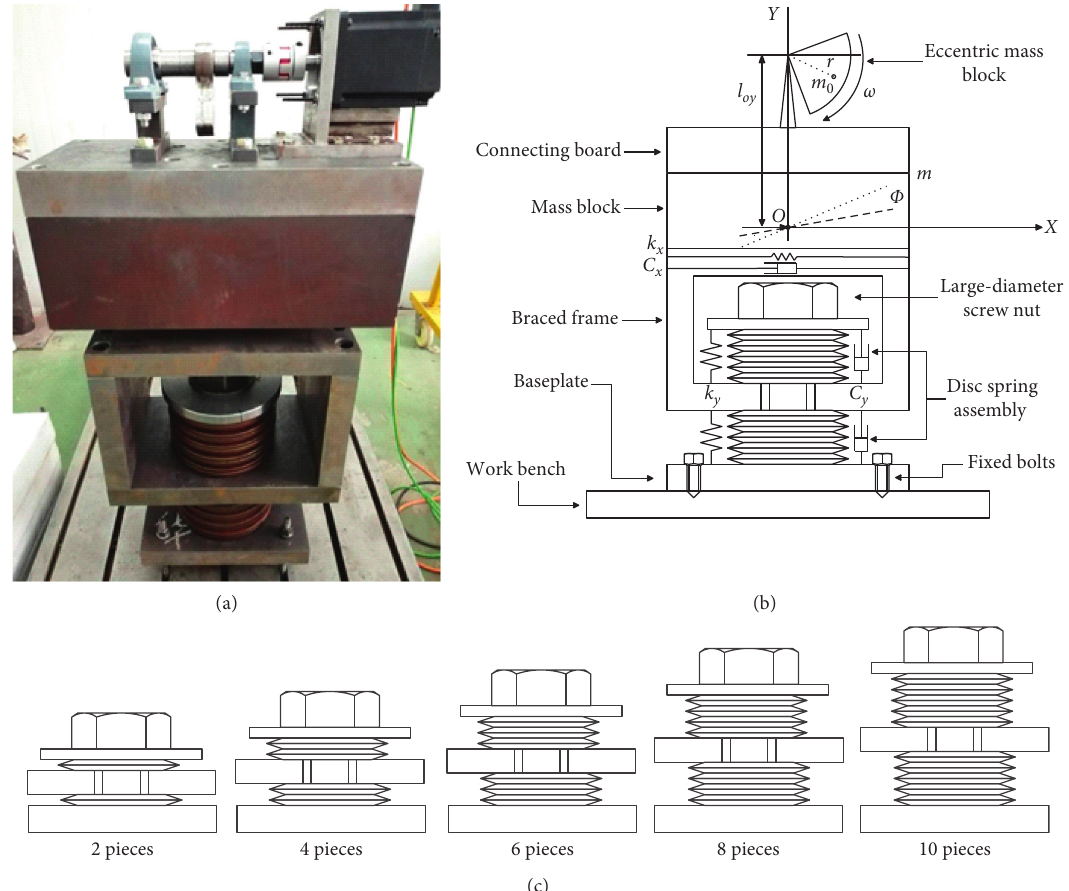
Figure 2: Disc spring vibration system: (a) experiment model, (b) structural sketch, and (c) different numbers of disc